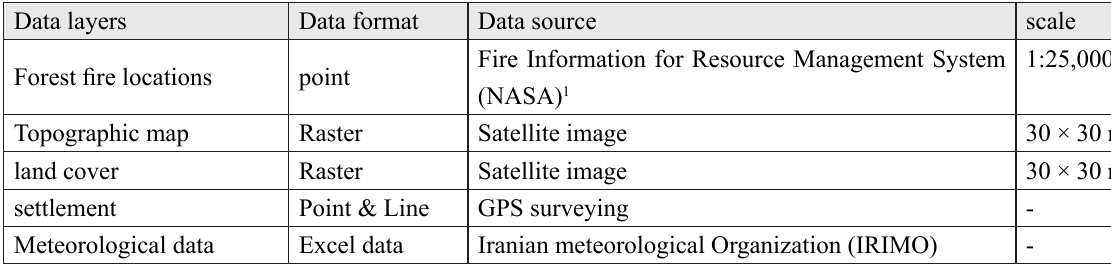
Table 2. Data used in fire hazard